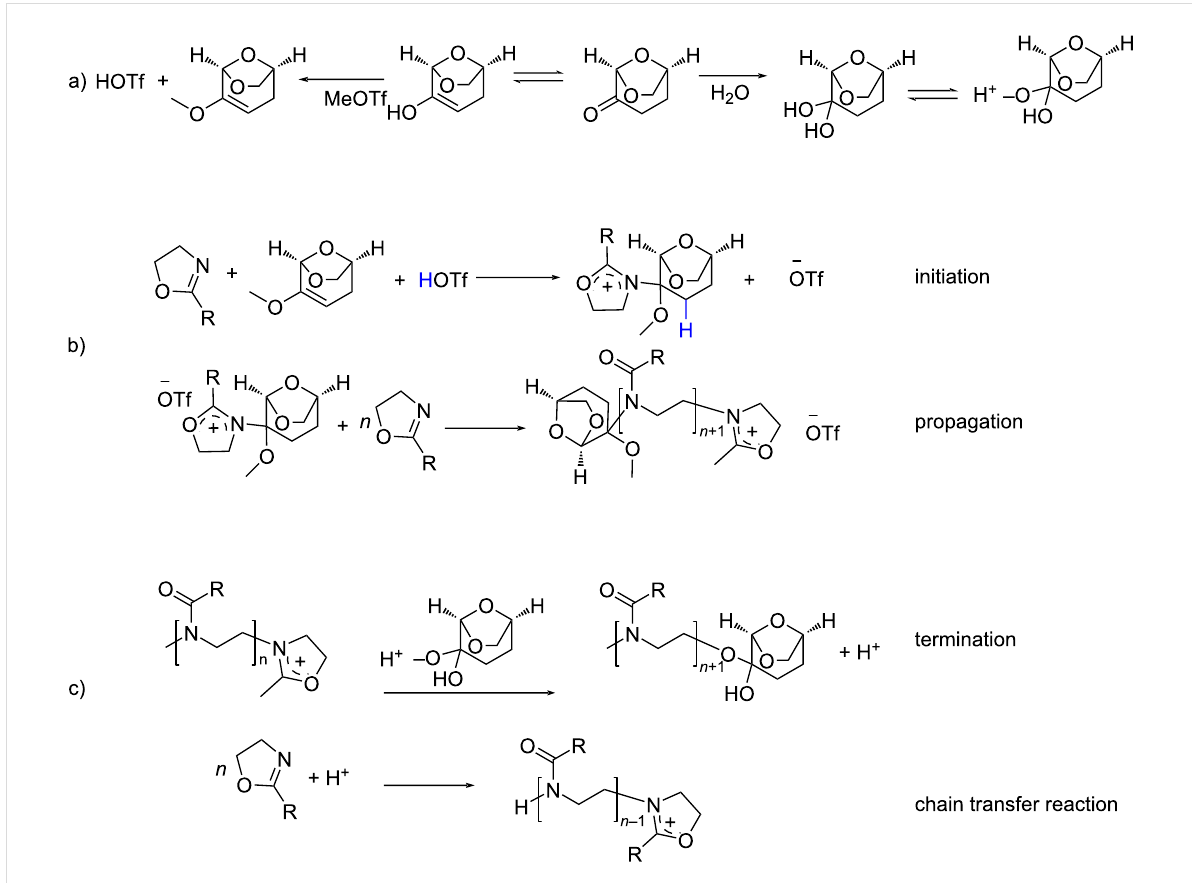
Figure 5: Schematic illustration of the side reactions that can occur during the polymerization of 2-alkyl-2-oxazoline in DLG.